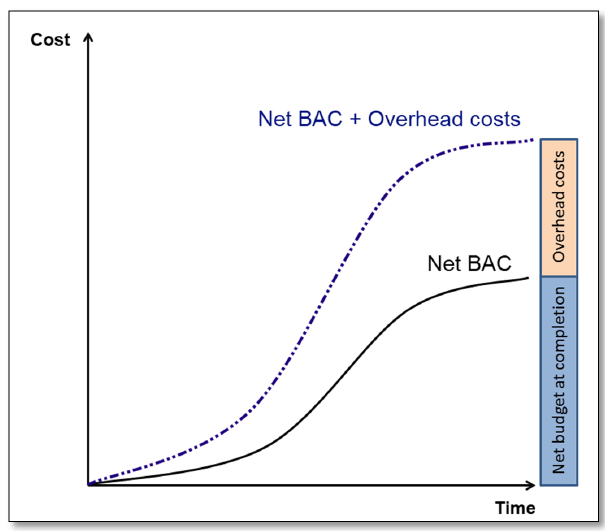
Fig. 3. Project baselines in two different